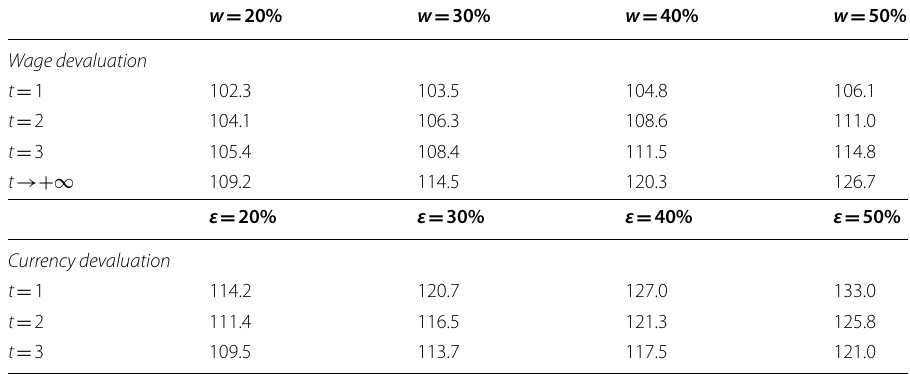
Table 9 The evolution of the international competitiveness (%); Italy